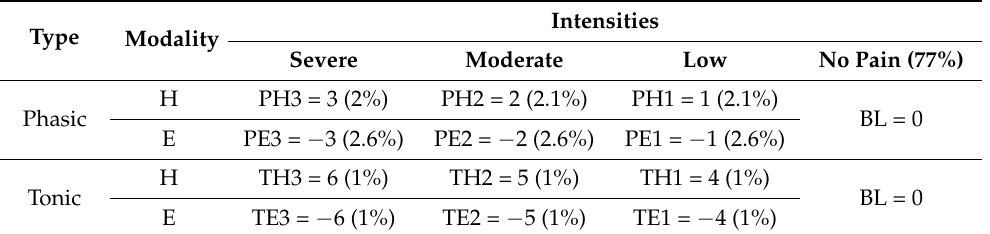
Table 1. List abbreviations of pain stimuli type, modalities, intensities, and numerical class labels with the percentage samples distribution. This table is also presented in our recent study [20–22]. Intensities Type Modality Severe Moderate Low